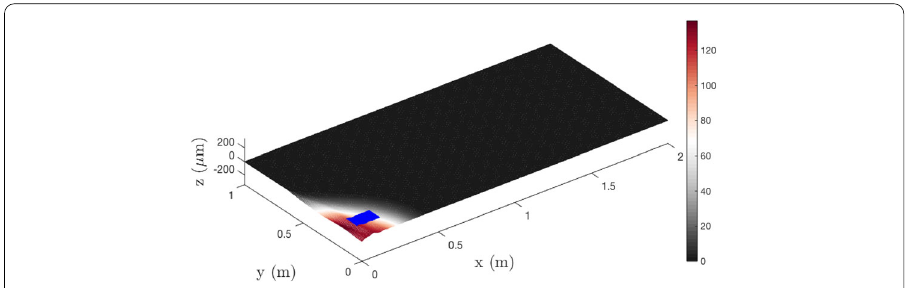
Fig. 3 Horizontal displacement field (expressed in µ m) of the pyrotechnic cutting simulation (when t = 85 µ s). The blue area shows the ROI analyzed via